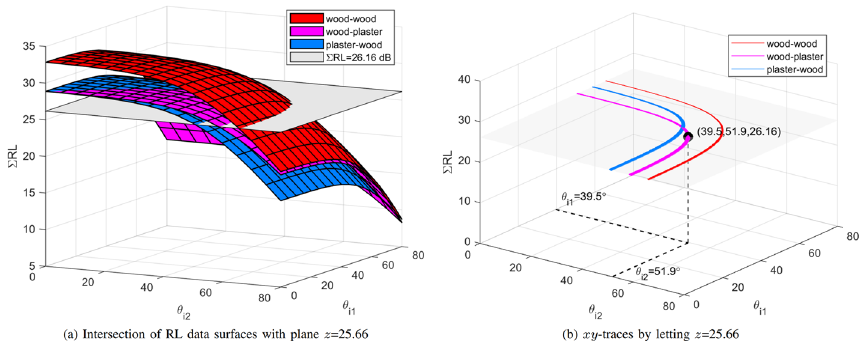
Fig. 9 All possible sequences-of-material and incident angles that induce RL of 26.16